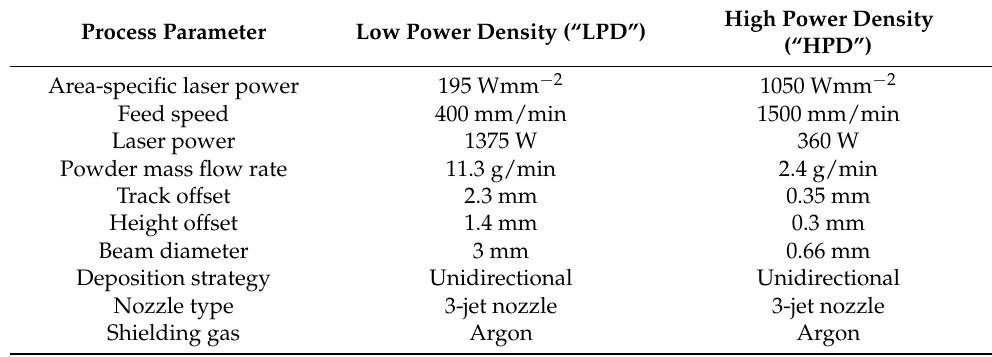
Table 2. HiperFer AM LMD process parameters.